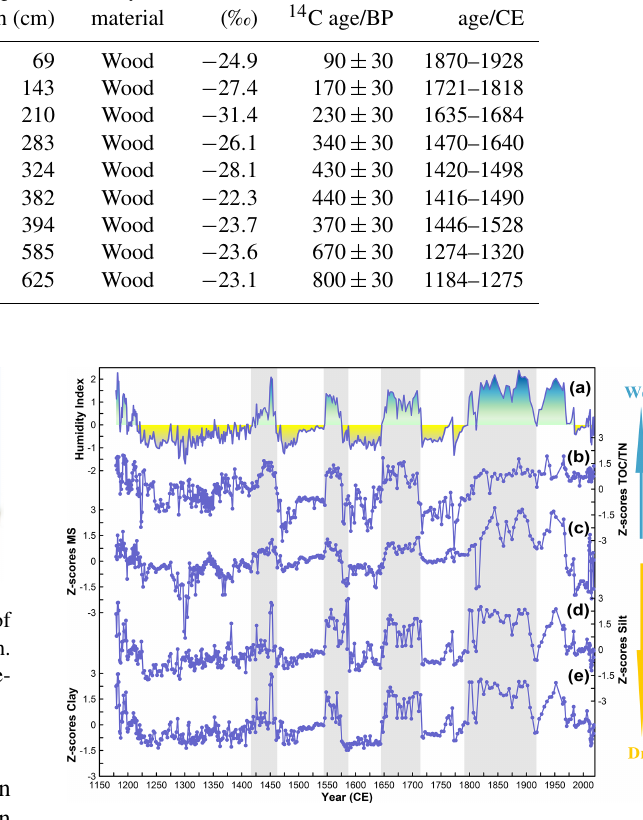
Figure 5. Humidity index reconstruction (a) based on the Z scores of total organic carbon / total nitrogen (TOC / TN) ratios (b) , the Z scores of magnetic susceptibility (MS) (c) , the Z scores of silt fraction (d) , and the Z scores of clay fraction variation (e) in the DLC1819 core in Lake Dalongchi. Light grey bars highlight inter- vals of increased humidity in Lake Dalongchi during the LIA.